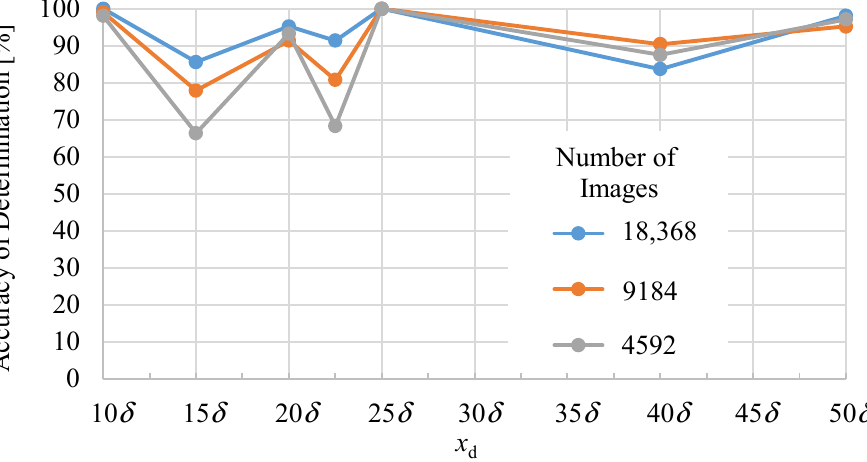
Figure A1. Dependency on the training number for W0.9 δ for the five-class classification problem.